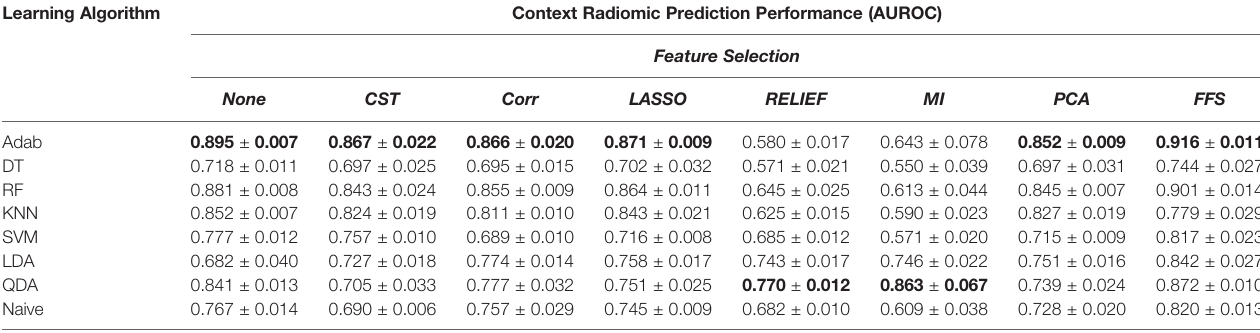
Learning Algorithm